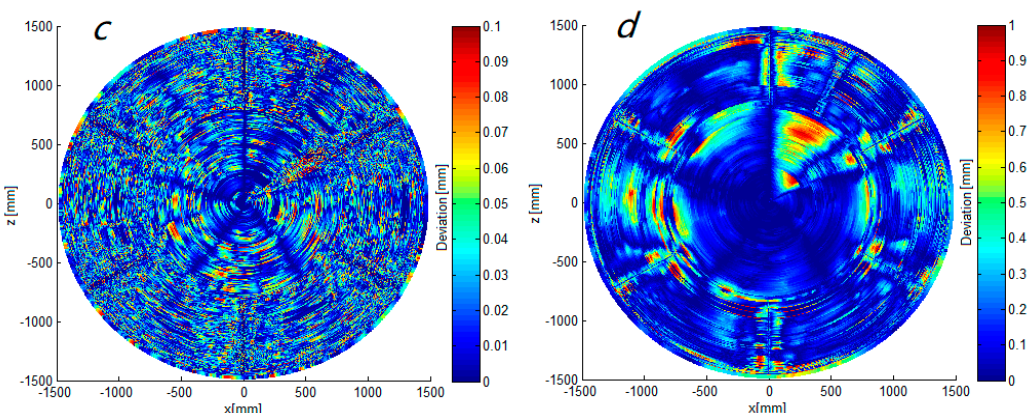
Figure 9. Spatial distributions of deviation under different required accuracies ε : ( a ) ε = 0.001 mm; ( b ) ε = 0.01 mm; ( c ) ε = 0.1 mm; ( d ) ε = 1 mm.